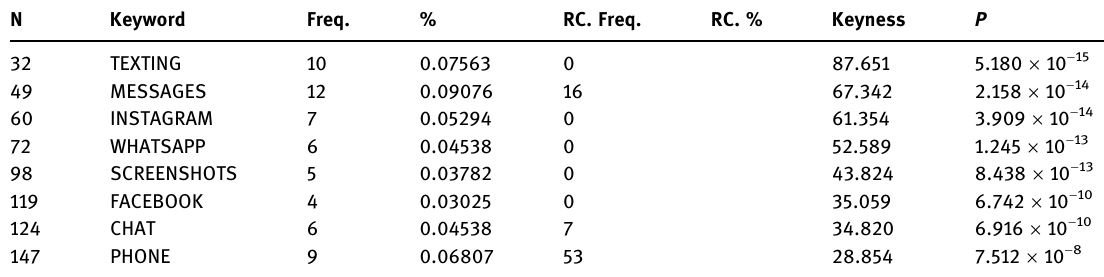
Table 42: Keywords relating to communication and social media N Keyword